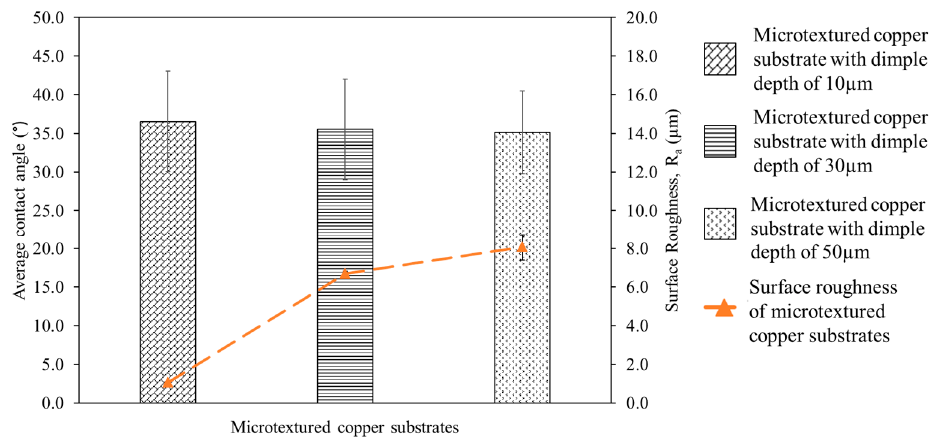
Figure 6. The average contact angle of the solder joint and surface roughness of microtextured copper substrates.